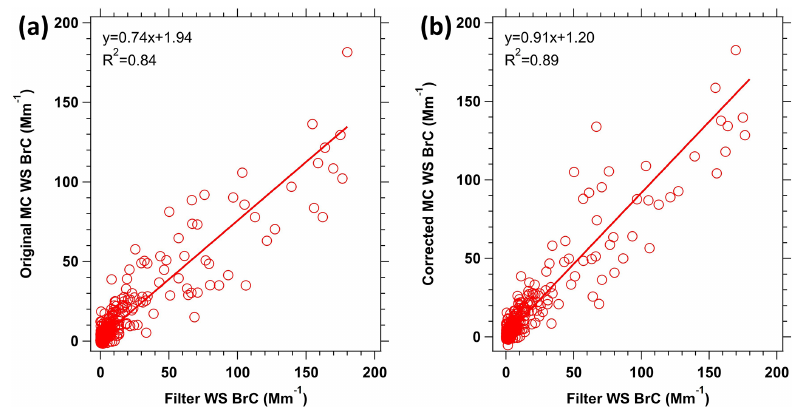
Figure 8. Comparison of the WS BrC determined online using the MC-LWCC vs. offline from extraction of filters. Panel (a) shows the original MC-LWCC WS BrC data, and panel (b) shows the MC data with the hysteresis correction applied. The data are fitted by orthogonal distance